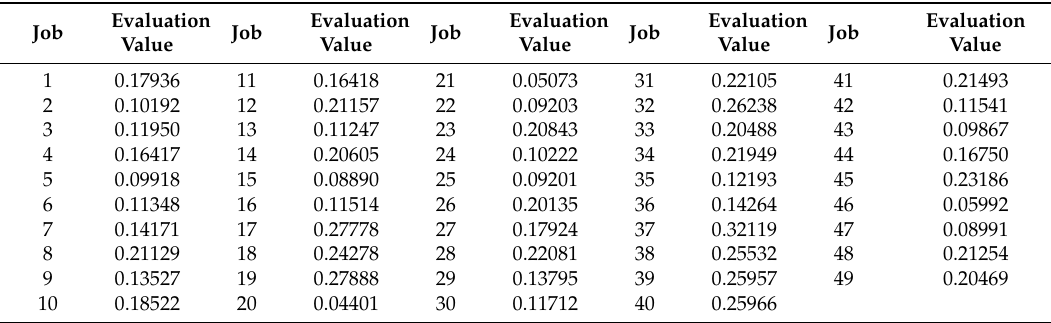
Table 10. Job complexity composite value.